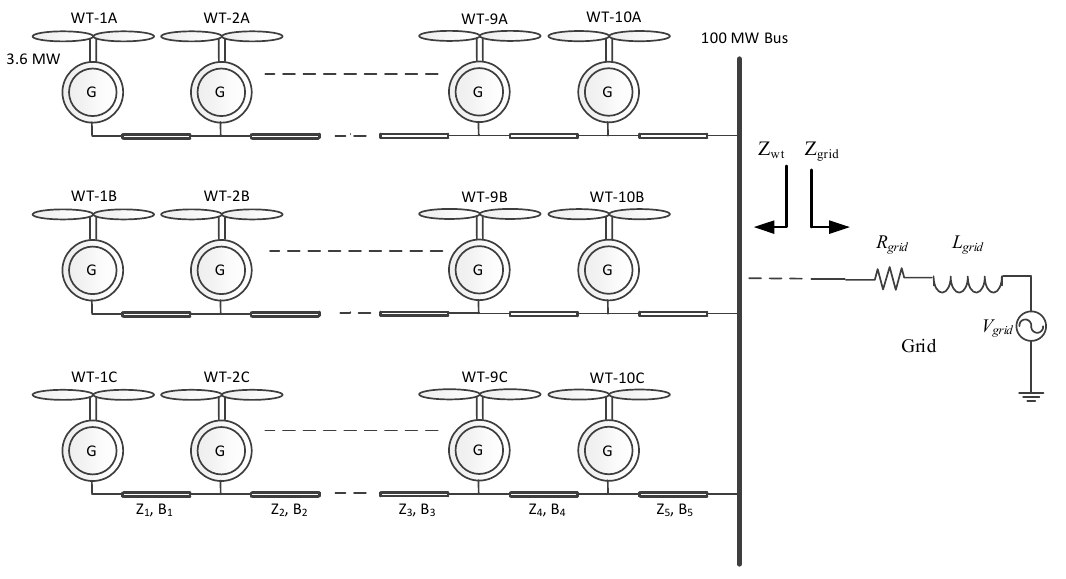
Figure 6. A 108 MW wind power plant, including three 36 MW strings.